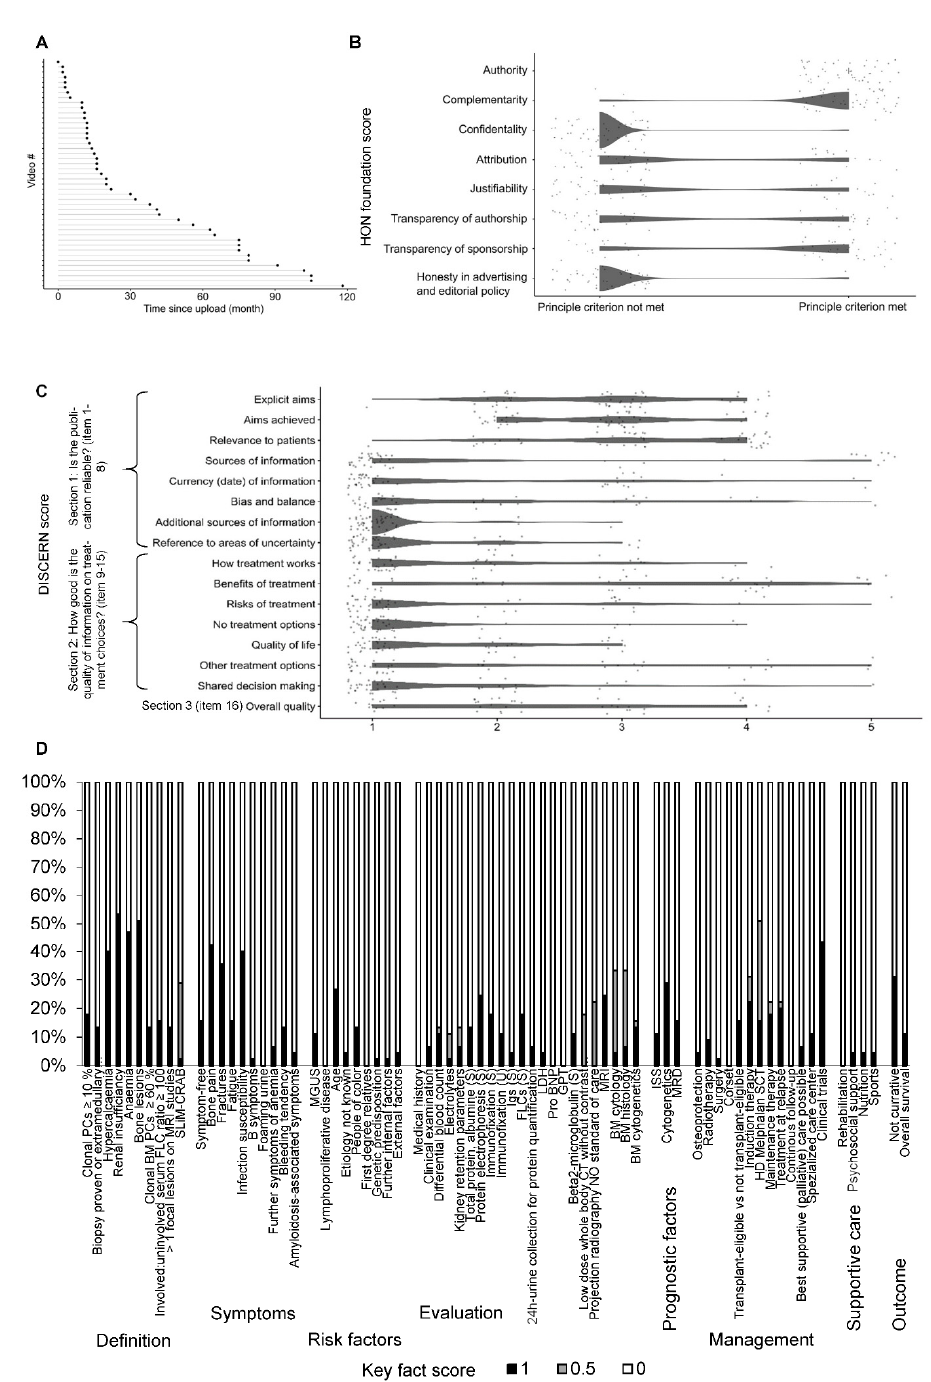
Figure 3. Characterization of unique videos. ( A ) The lollipop plot shows the videos ordered by their time since upload until the date of assessment in months. ( B ) A scatter dot plot shows the score result reached by every single video ( n = 45) for each item of the HON foundation score (0, principle criterium not met; 1, principle criterium met). To avoid a visual overlap the dots were spread around the respective score category. ( C ) A scatter dot plot shows the score result reached by every single video ( n = 45) for each item of the DISCERN score. The categorial item scoring ranges between 1 (not addressed/fulfilled) and 5 (fully addressed/fulfilled). To avoid a visual overlap the dots were spread around the respective score category. ( D ) For each of the 73 key fact items, the proportion of videos ( n = 45) fully (1), partially (0.5) or not (0) addressing the respective contents is shown. The results are grouped by key fact